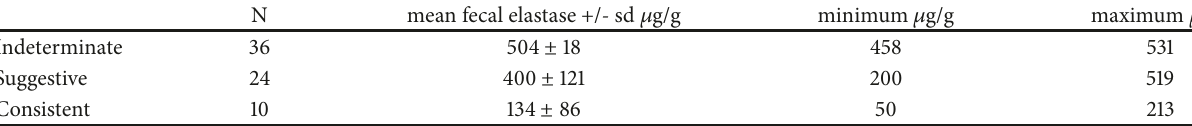
Table 1: Descriptive data according to fecal elastase levels of the study population.